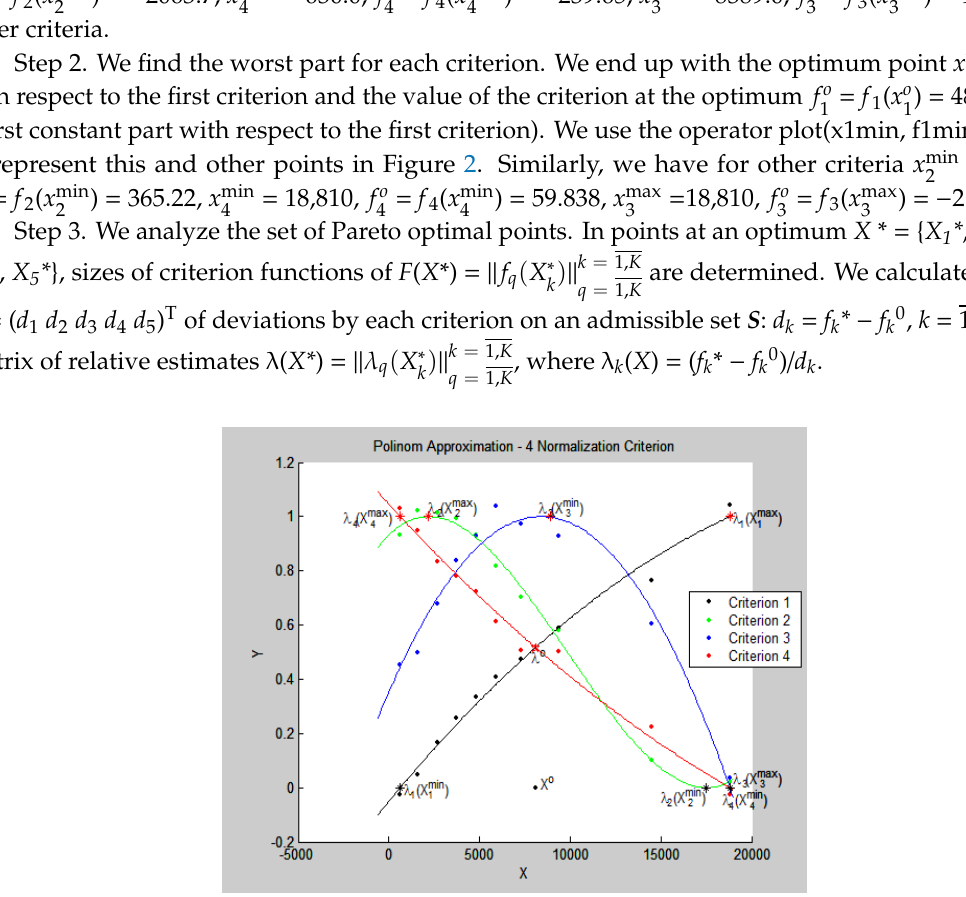
Figure 2. Approximations of four normalized criteria.